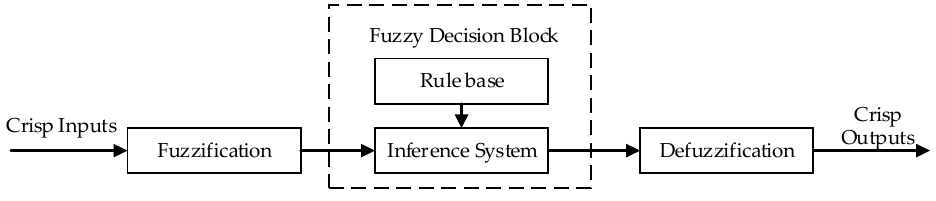
Figure 3. Basic block diagram of a fuzzy logic system (FLS).